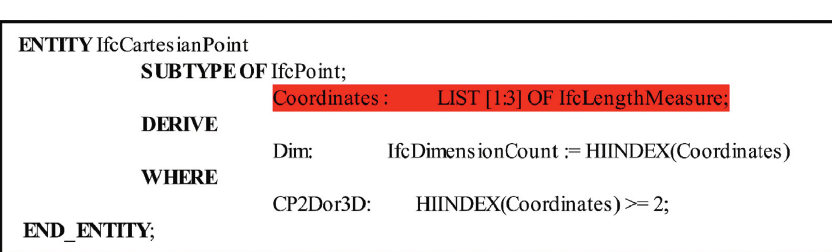
Figure 1: IFC instance cross-reference fragment.